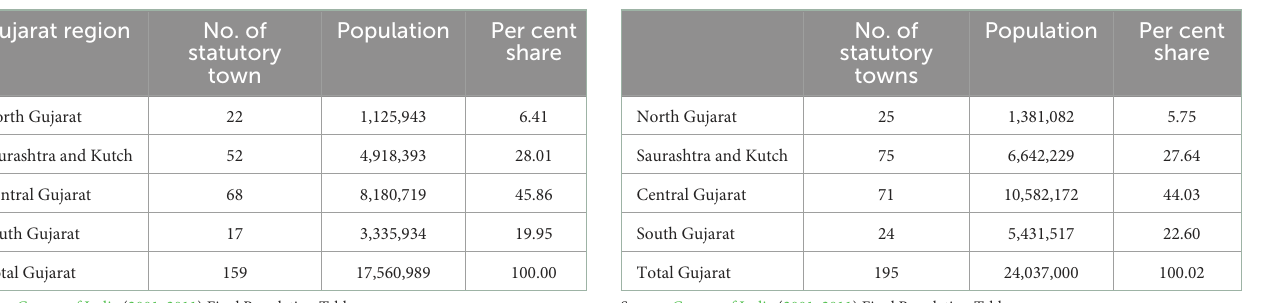
TABLE 7 Statutory towns in Gujarat, 2001. TABLE 8 Statutory towns in Gujarat, 2011.